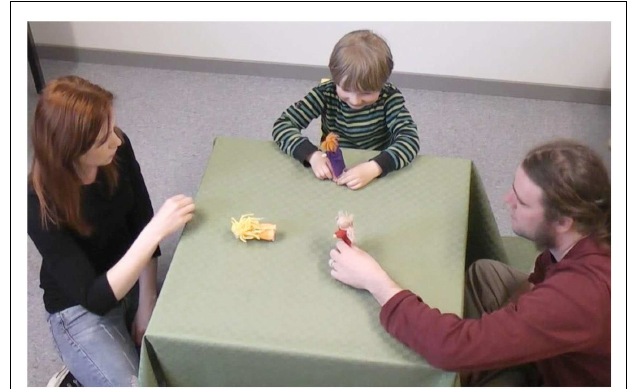
FIGURE 1 | Still from video recording of procedure. Depicted is the moment during story retelling when one child doll has attacked the other, just before the participant is invited to select actions for the adult